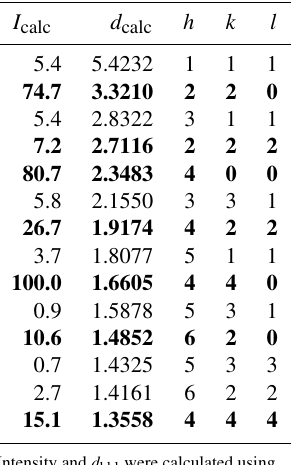
Table 4. Calculated X-ray powder diffraction data for grimmite.